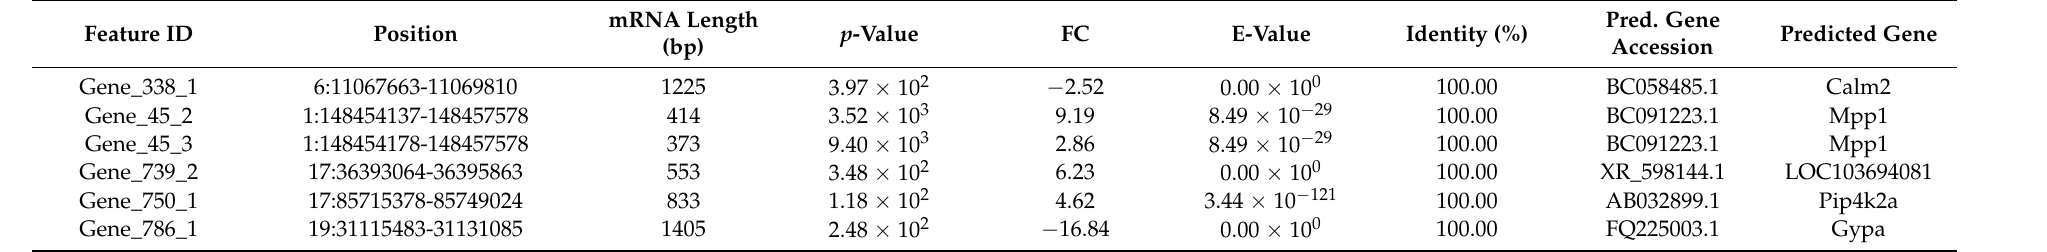
Table 2. Differentially expressed novel transcripts associated with non-annotated genes in blood.